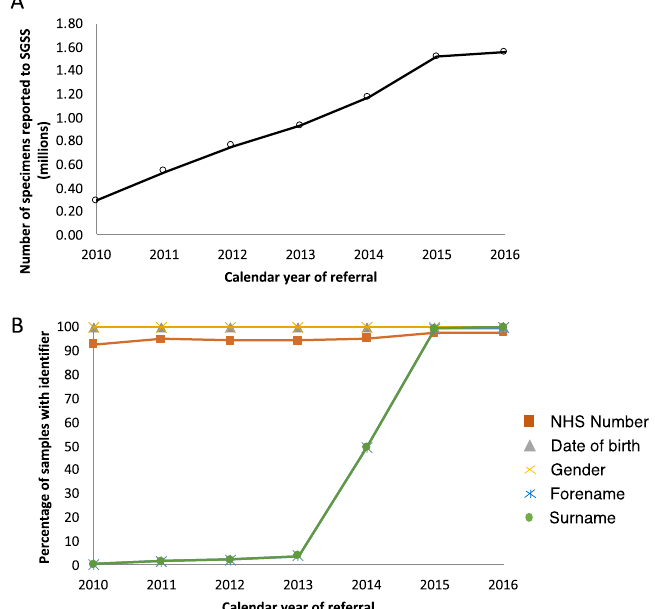
Figure 2. The numbers of specimens reported to SGSS ( A ) and the percentage of those specimens with various identifiers ( B ).